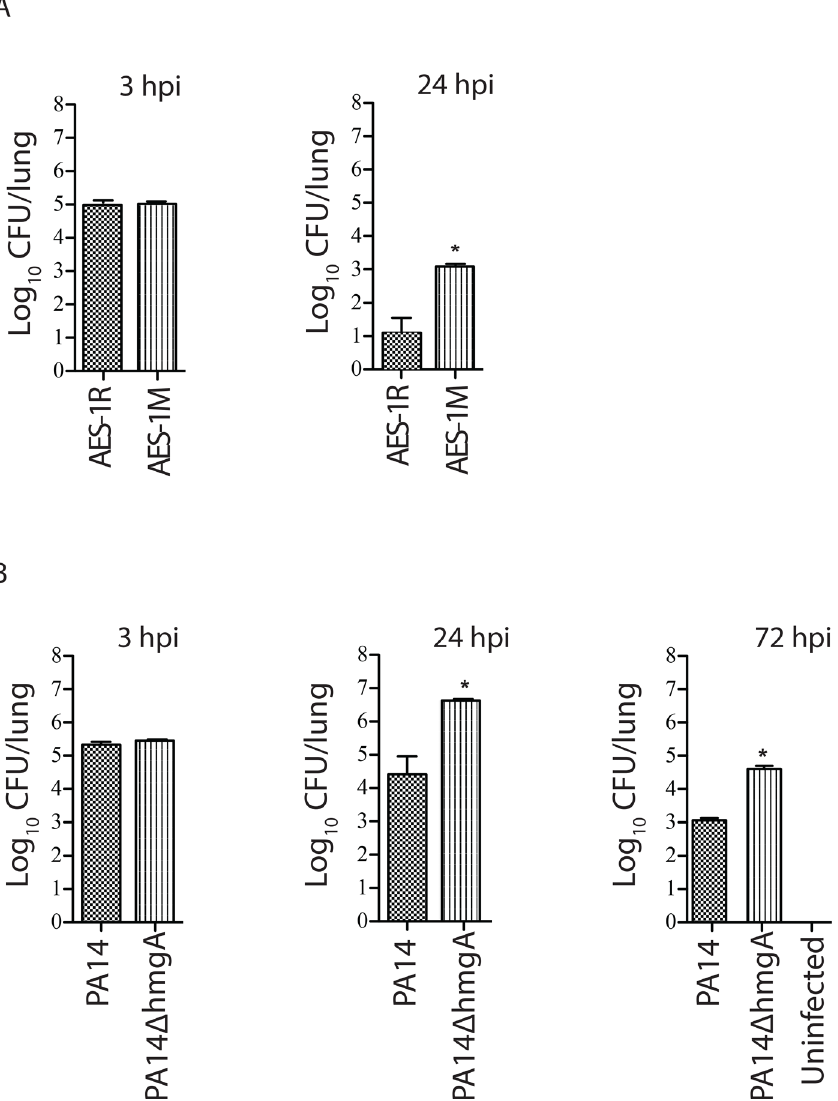
Fig 2. Persistence of P . aeruginosa AES-1R, AES-1M and PA14, PA14 hmgA , in a C57BL/6 mouse model. A . Mice were infected with 10 6 CFU of AES-1R and AES-1M and lungs examined at 3-hrs and 24-hrs and 72hrs post-infection for bacterial load (latter not shown). B. Mice were infected with 10 6 CFU wildtype PA14 and PA14 hmgA and lungs were examined at 3-hrs, 24-hrs, and 72-hrs post-infection for bacterial load. AES-1M was recovered at significantly higher level compared to AES-1R at 24-hr. PA14 Δ hmgA was recovered at a significantly higher level compared to the wild type PA14 at 24- and 72-hrs post-infection. The significances of differences between strains were determined by ANOVA. 4A: * p < 0.001vs AES-1R; 4B * p < 0.0001 vs. PA14